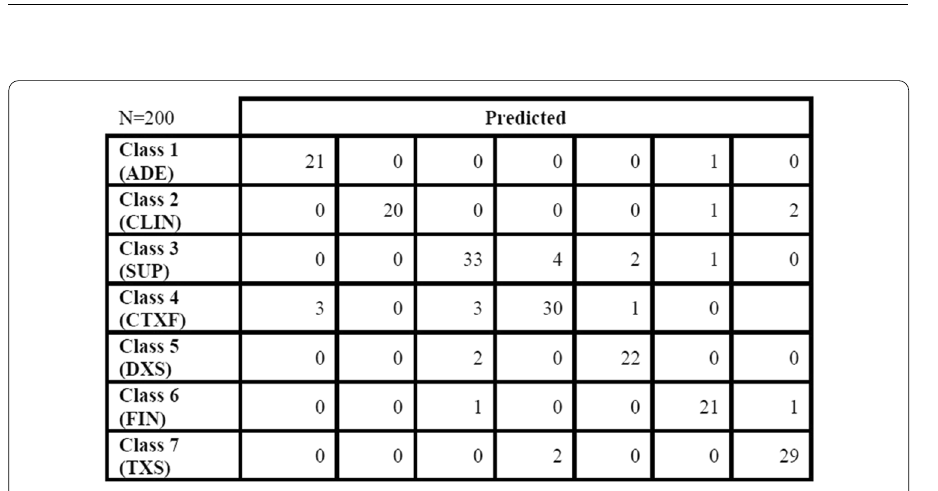
Fig. 5 Confusion matrix for the predicted class in the